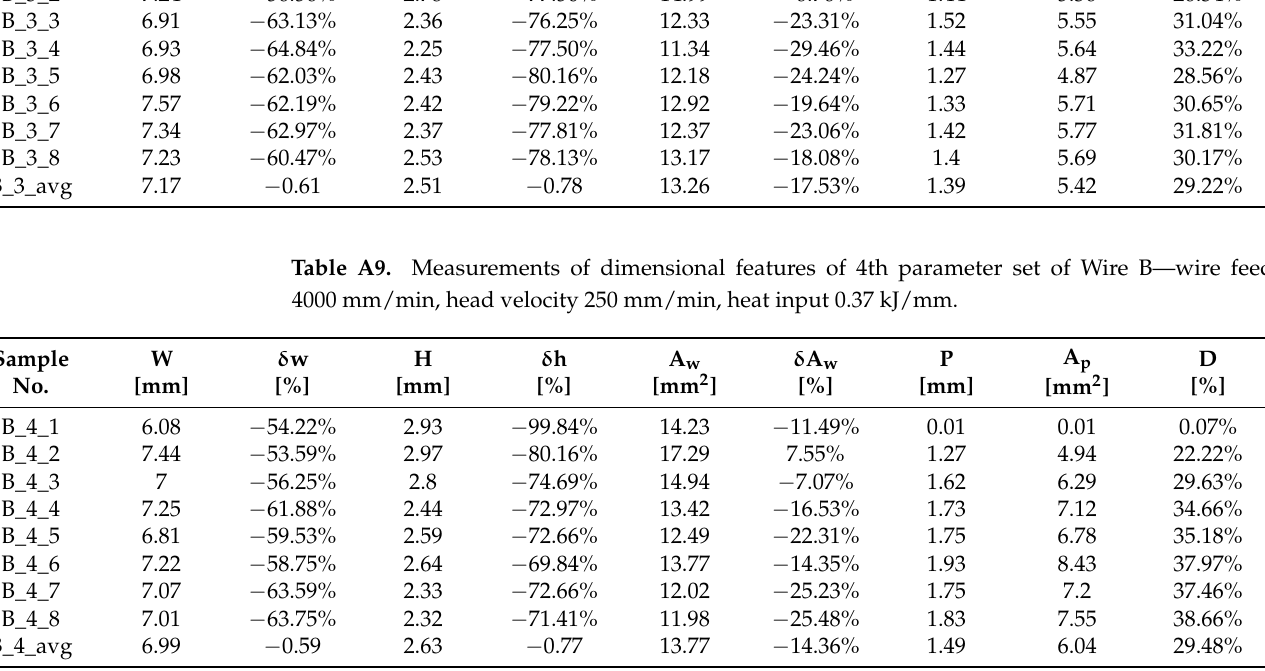
Table A10. Measurements of dimensional features of 5th parameter set of Wire B—wire